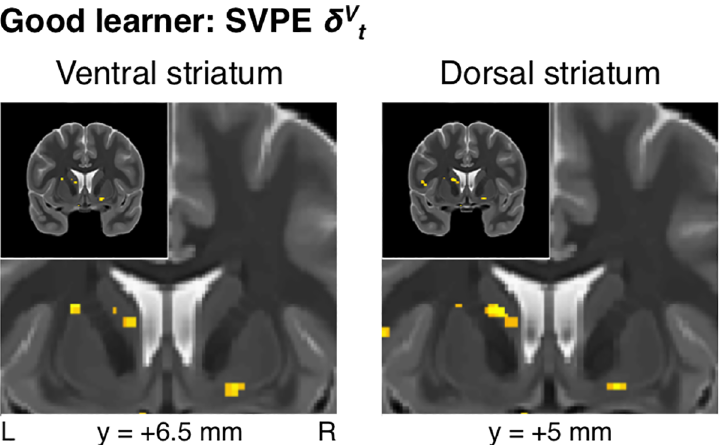
Good-learner group ( p < 0.005 unc., SVC p FWE < 0.05).